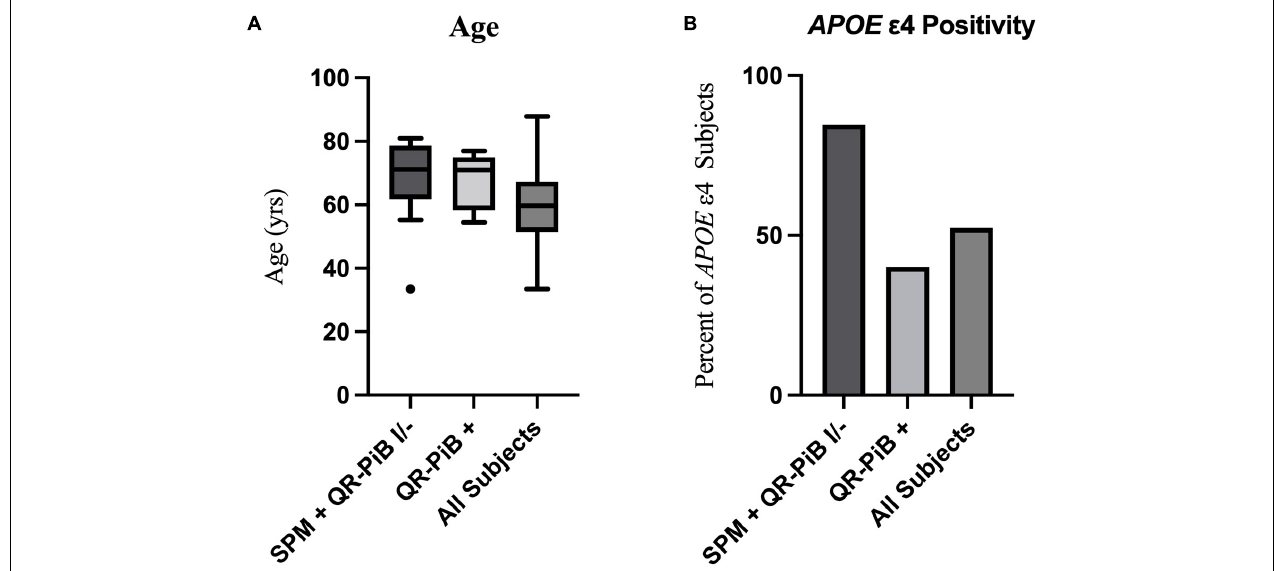
FIGURE 3 | A visual representation of the age distribution with a Tukey box and whisker plot (outlier, black dot) (A) and percent of APOE ε 4 positive subjects (B) in the SPM +, QR-PiB I/ − subgroup ( n = 14), the QR-PiB + subgroup ( n = 11), and the entire test cohort (All Subjects, n = 115). There is no significant difference in age between the SPM+, QR-PiB I/ − subgroup and the QR-PiB + subgroup (A) , but the SPM+, QR-PiB I/ − subgroup identifies a higher percentage of APOE ε 4 positive subjects than the QR-PiB + subgroup (B) .